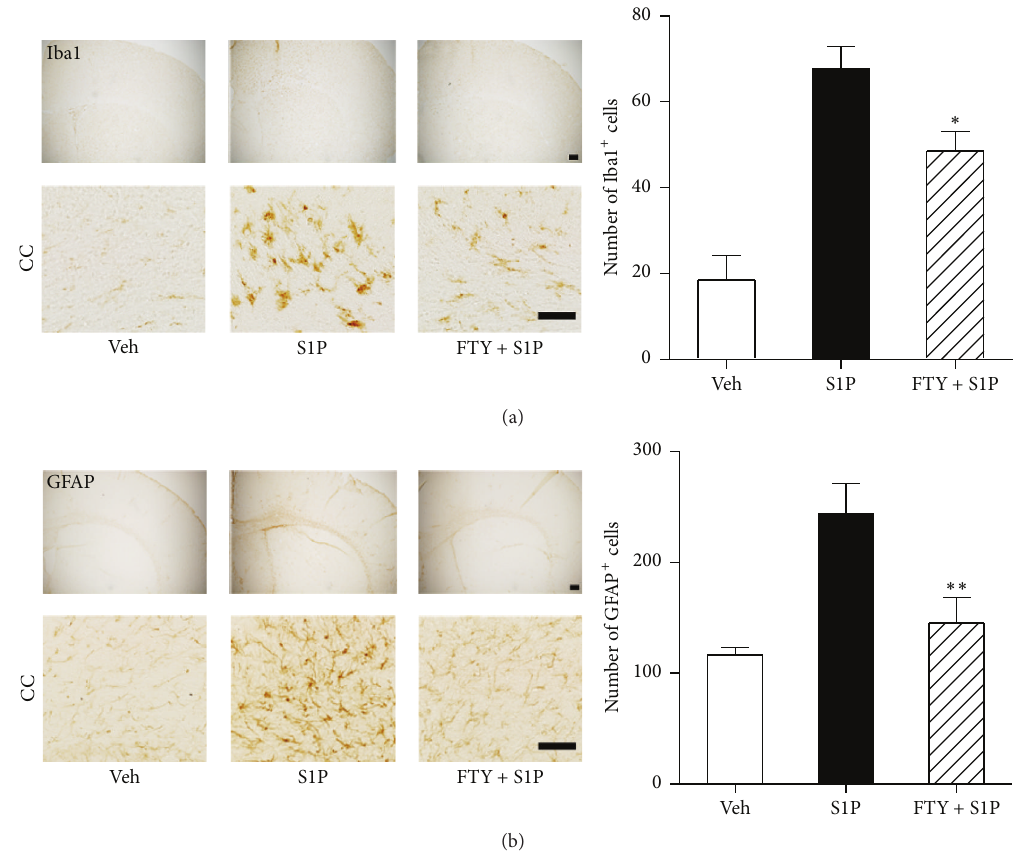
Figure3:MicrogliaandastrocytesareactivatedinthebrainfollowingS1Pmicroinjectionintothecorpuscallosum.S1Pwasmicroinjectedinto the corpus callosum (CC), and activation of microglia or astrocytes was assessed 1 day after microinjection. FTY720 (FTY) was administered 30 min prior to S1P microinjection. Representative microphotographs of brain sections immunolabeled against Iba1 (a) or GFAP (b) and their quantitative analysis in groups of vehicle (veh), S1P, and FTY + S1P. ∗ 𝑃 < 0.05 and ∗∗ 𝑃 < 0.01 , compared with the S1P-injected group (S1P) (Newman-Keuls test). 𝑛 = 5 per group. Scale bar, 200 (upper panel) or 50 𝜇 m (lower